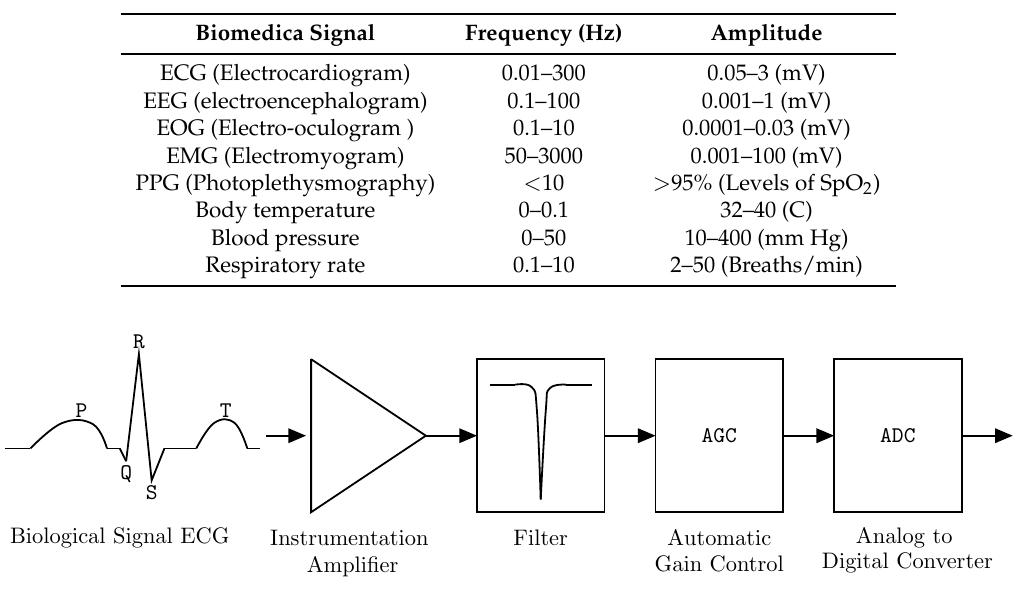
Table 1. Characteristics of biomedical signals.